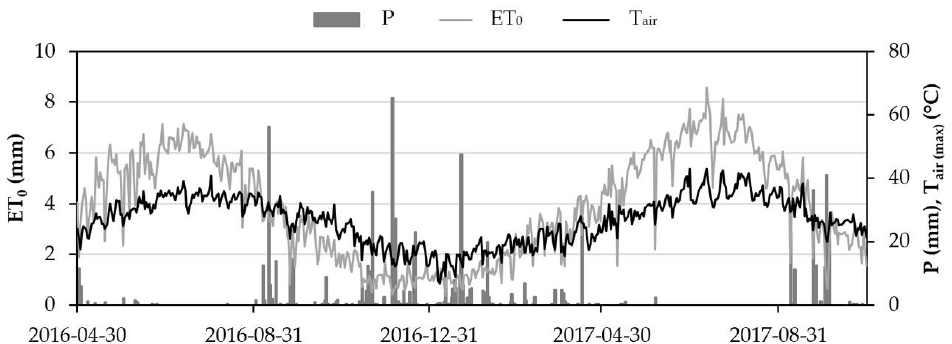
Figure 3. Temporal evolution of weather parameters used to implement the soil water balance (SWB) model within the dual K c FAO-56 approach. Values refer to the reference period (April 2016–October 2017). P is the precipitation (mm); ET 0 is the reference evapotranspiration (mm); and T air is the air temperature ( ◦